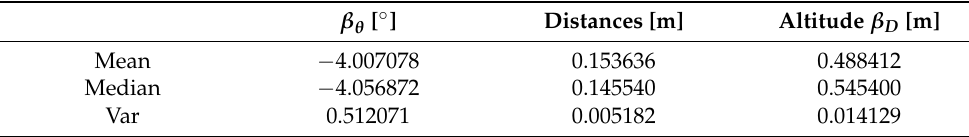
Table 3. Stationary